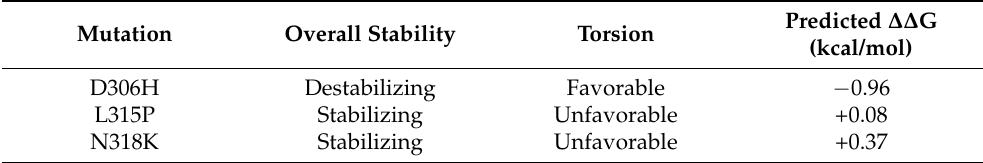
Table 2. CUPSAT analysis of PRMT5 mutant stability.